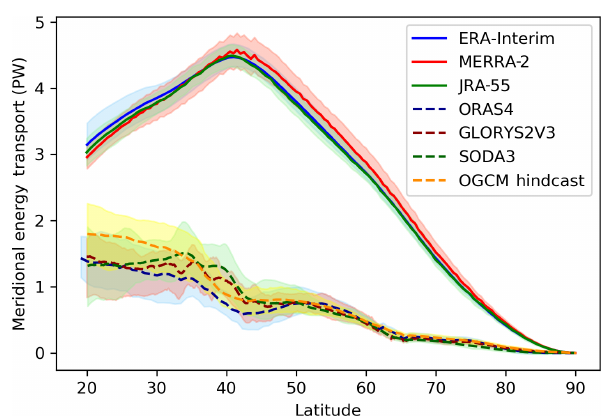
Figure 2. Mean AMET and OMET over the entire time span of each product as a function of latitude in the Northern Hemisphere. AMET is illustrated with solid lines and OMET with dashed lines. The shades represent the full range of MET across the entire time series at each latitude. The time span of each product used in this study is given in Table